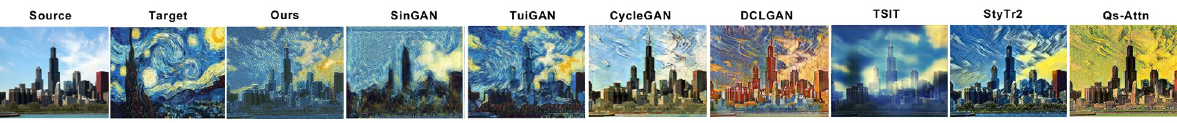
Fig 8. Translation results of CRPGAN with various baselines on Photo ! Van